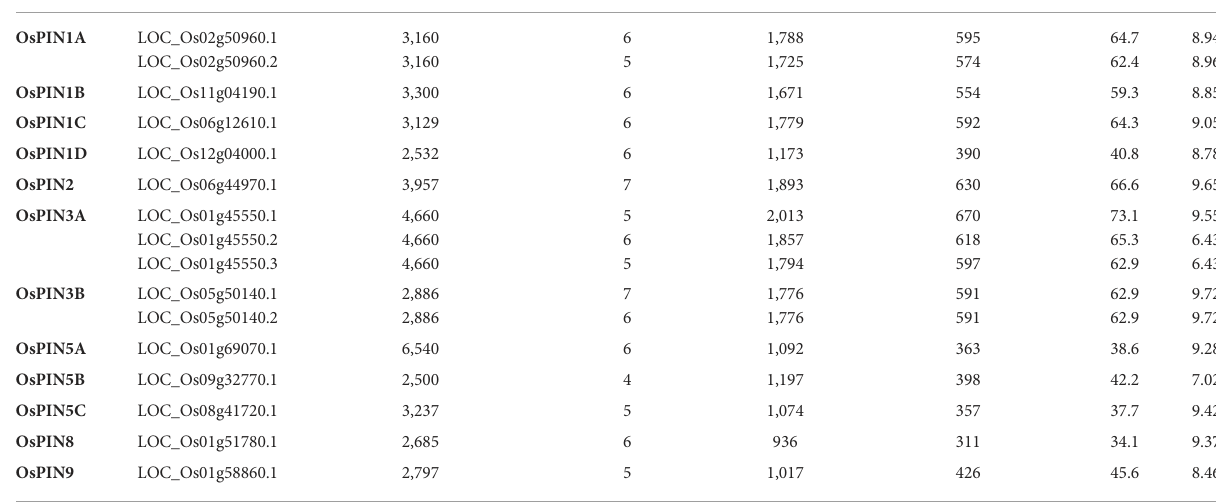
TABLE 1 List of the 12 PIN genes identi fi ed in the rice ( Oryza sativa ) genome. Gene name Locus